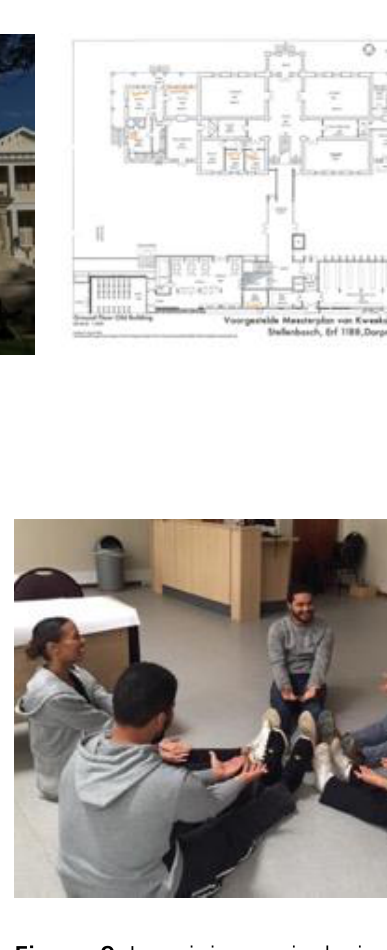
Figure 8 : Participants taking part in body sculpture